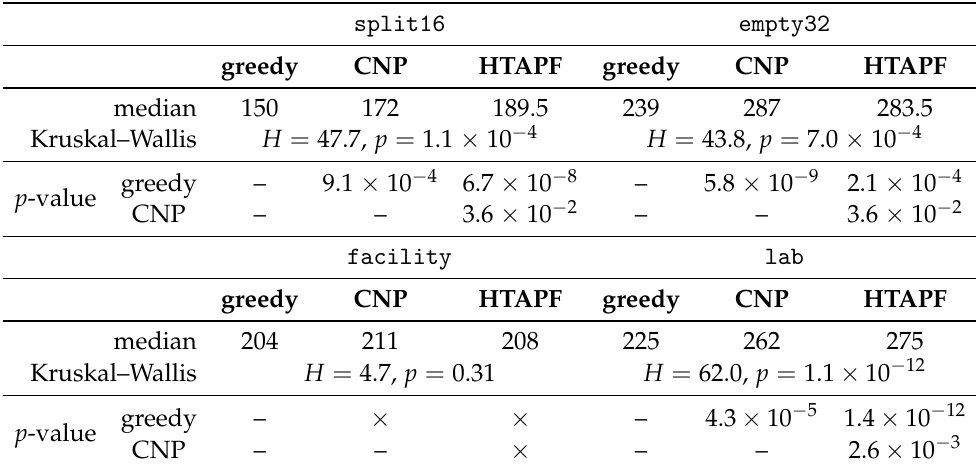
Table 1. Results of the statistical tests on the simulations performed with unlimited communication and no robot failures.